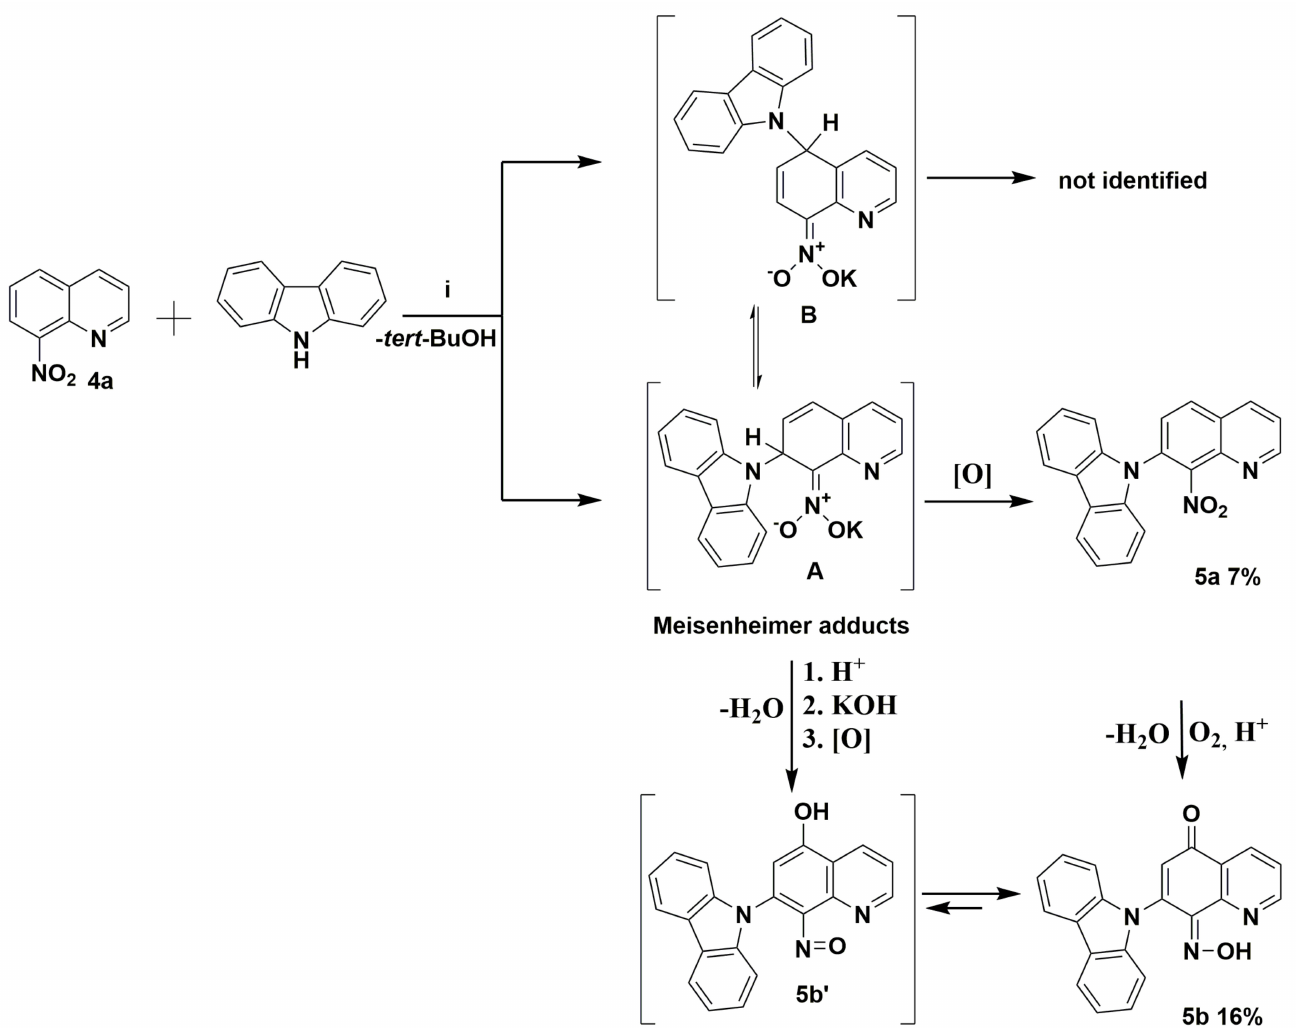
Scheme 2. Proposed mechanism of the reaction between the potassium carbazol-9-ide and nitroquinoline 4a . Reagents and conditions: ( i ) 9 H -carbazole, tert -BuOK, THF, and